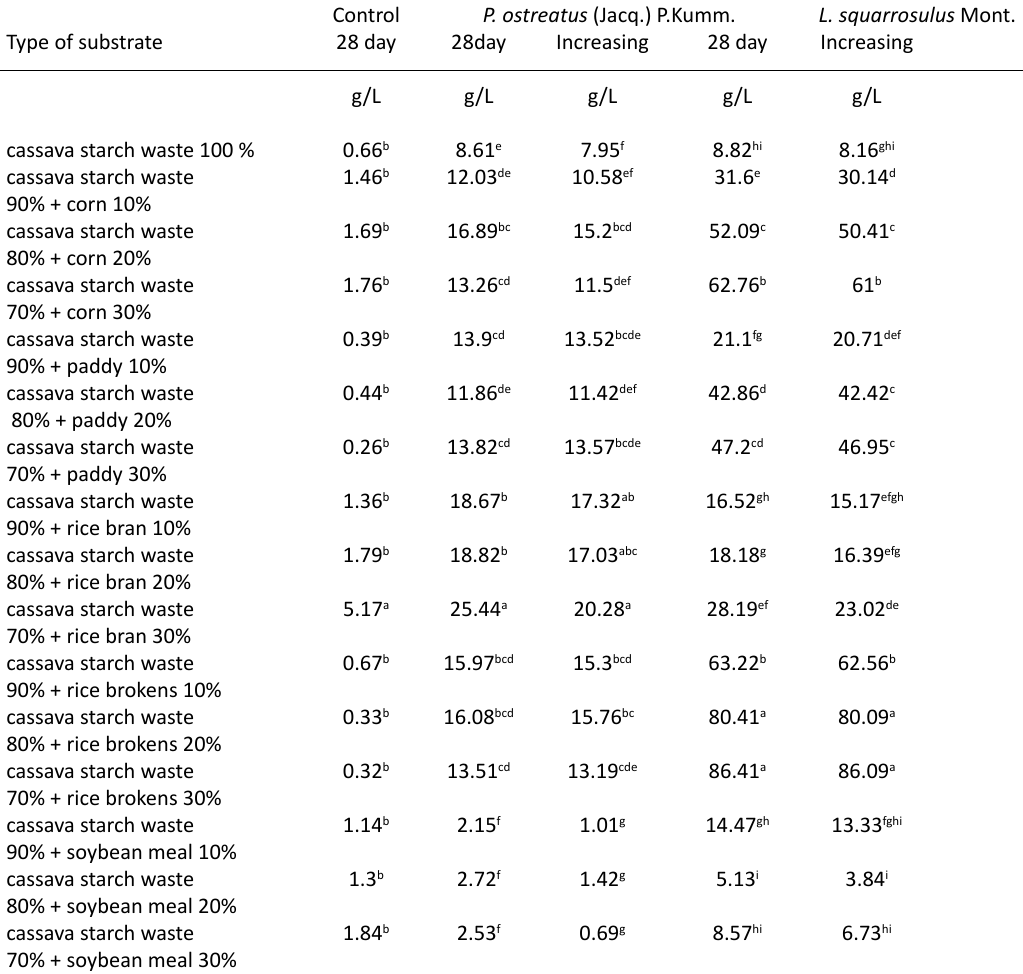
Table 2. Effect of P. ostreatus (Jacq.) P.Kumm. and L. squarrosulus Mont. on reduced sugar content at 28 day (g/L) Control P. ostreatus (Jacq.)